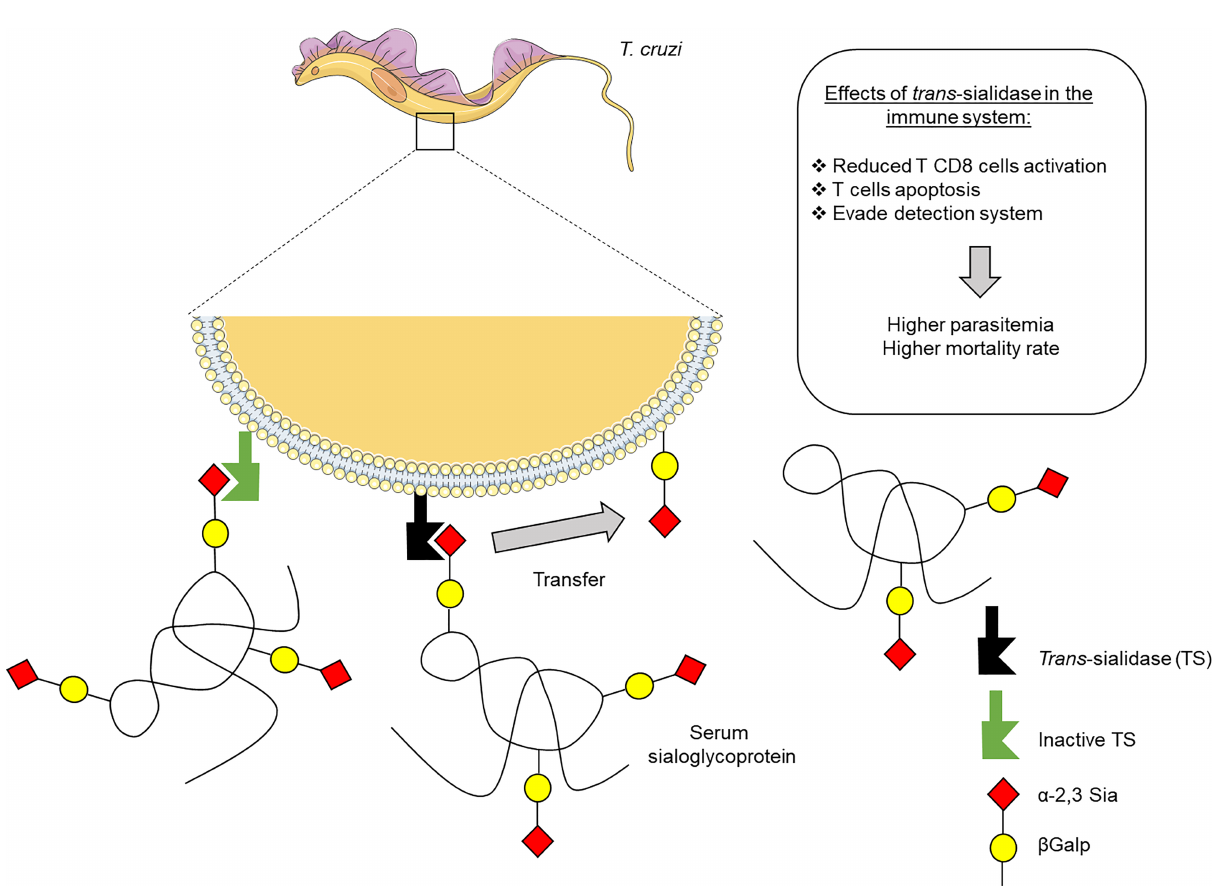
FIGURE 1 | Effects of Trypanosoma cruzi trans -sialidase (TS) on the host immune system. The TS enzyme can be secreted by parasite or anchored in the membrane of trypomastigote forms of T. cruzi . The active form incorporates sialic acid from host sialoglycoproteins to acceptor molecules in the parasite membrane. The inactive form has no enzymatic activity and functions as a lectin. This sialylation allows the escape of parasite from detection by the immune system, allowing its survival and the establish the